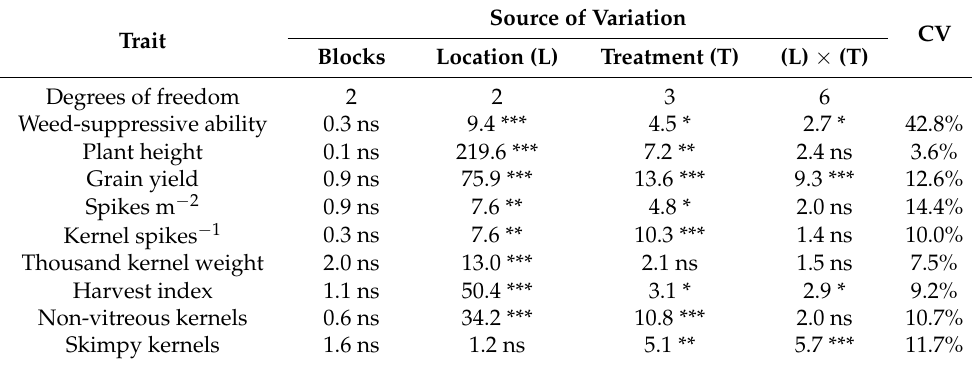
Table 1. F -values of the main effects and their interactions resulting from two-way analysis of variance (ANOVA) on the morphological and productive traits of durum wheat.